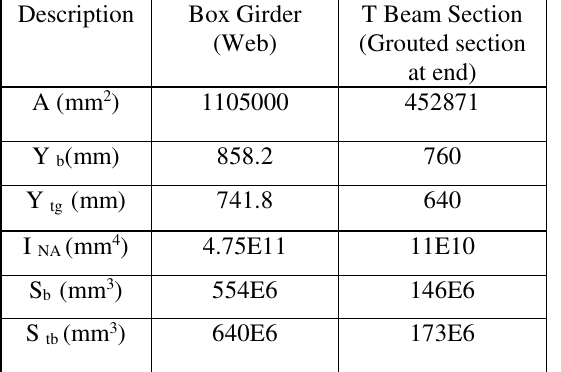
TABLE 2. GEOMETRICAL PROPERTIES OF SELECTED BOX AND T BEAM GIRDER BRIDGE Description